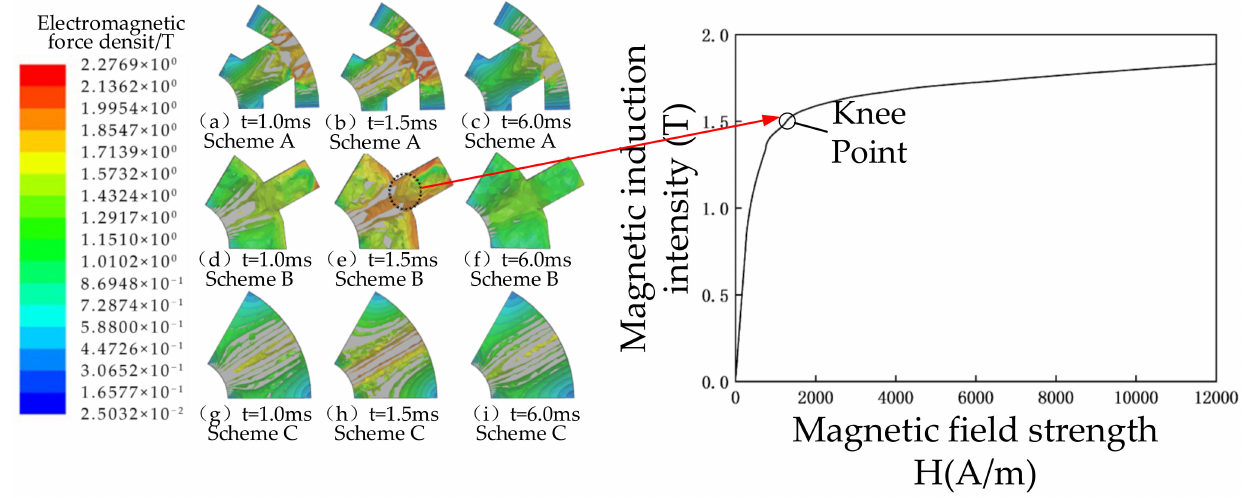
Figure 20. Comparison of armature magnetic induction distribution clouds before and after